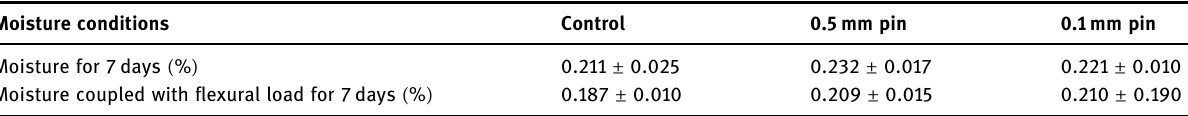
Table 1: Moisture content of composites under di ff erent moisture conditions Moisture